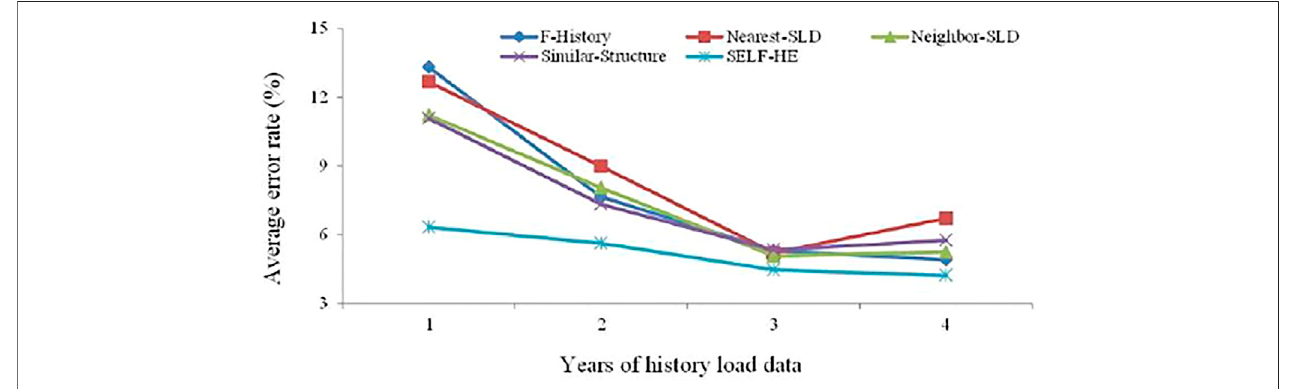
FIGURE 10 | Trends of average error rate with respect to the historical data